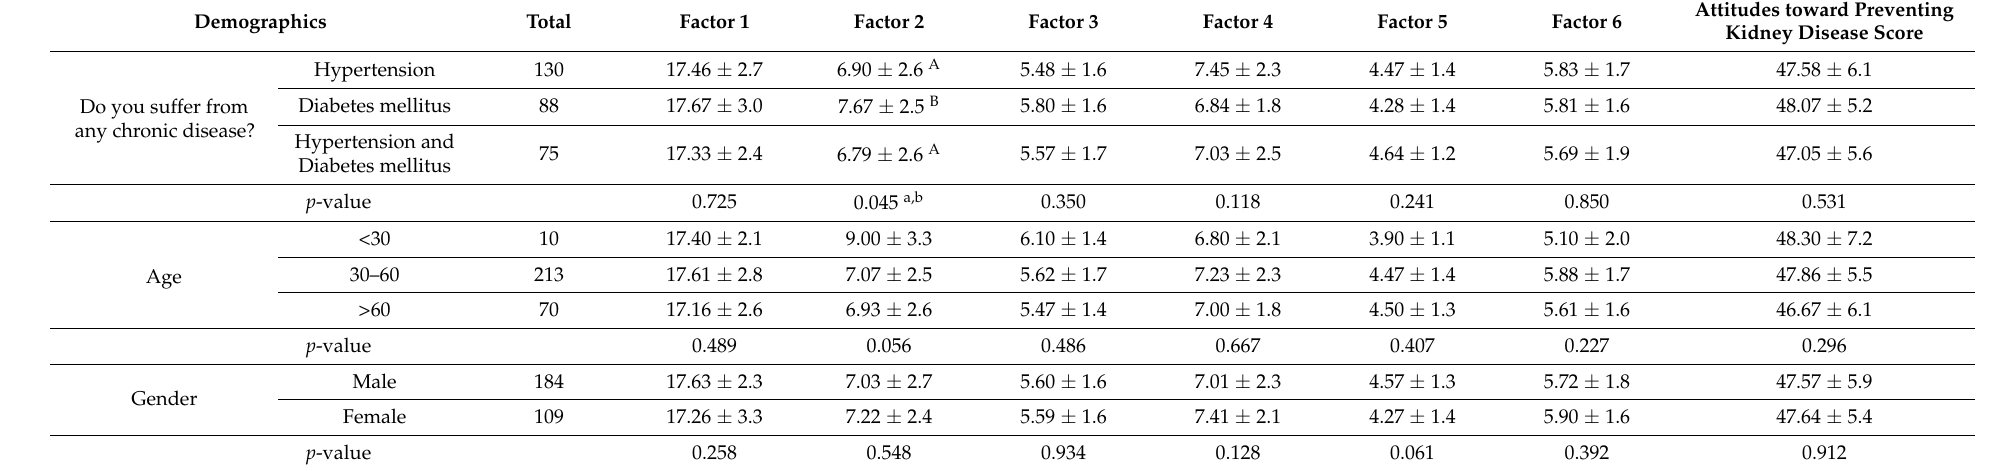
Table 3. Statistical analysis on participants’ attitudes toward preventing kidney